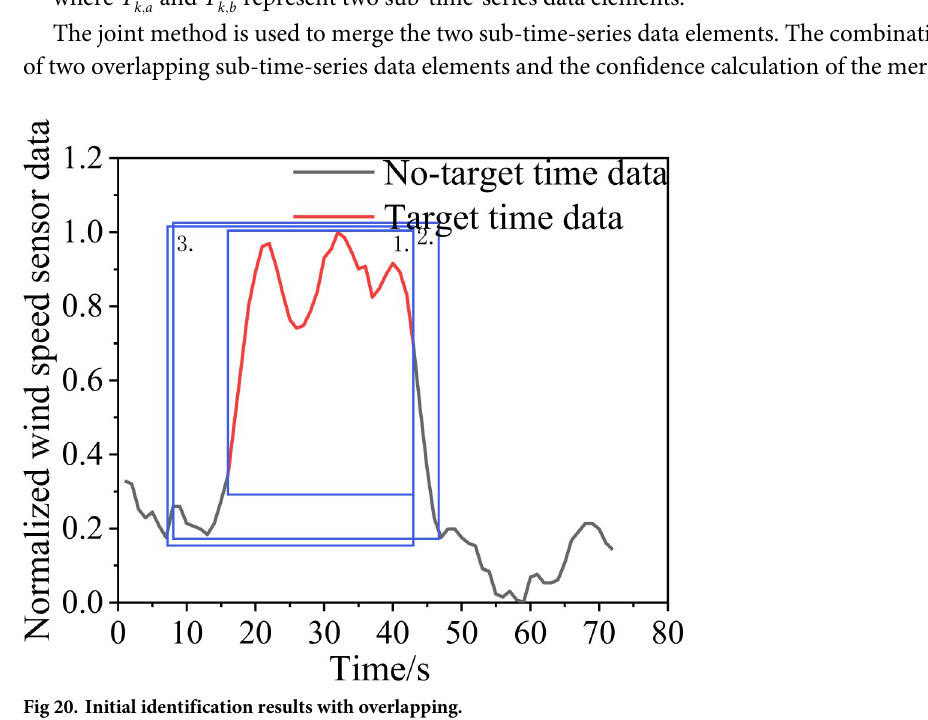
An overlap of two sub-time-series data elements is indicated by an IoU value between them that exceeds 0. The IoU value is calculated as follows: